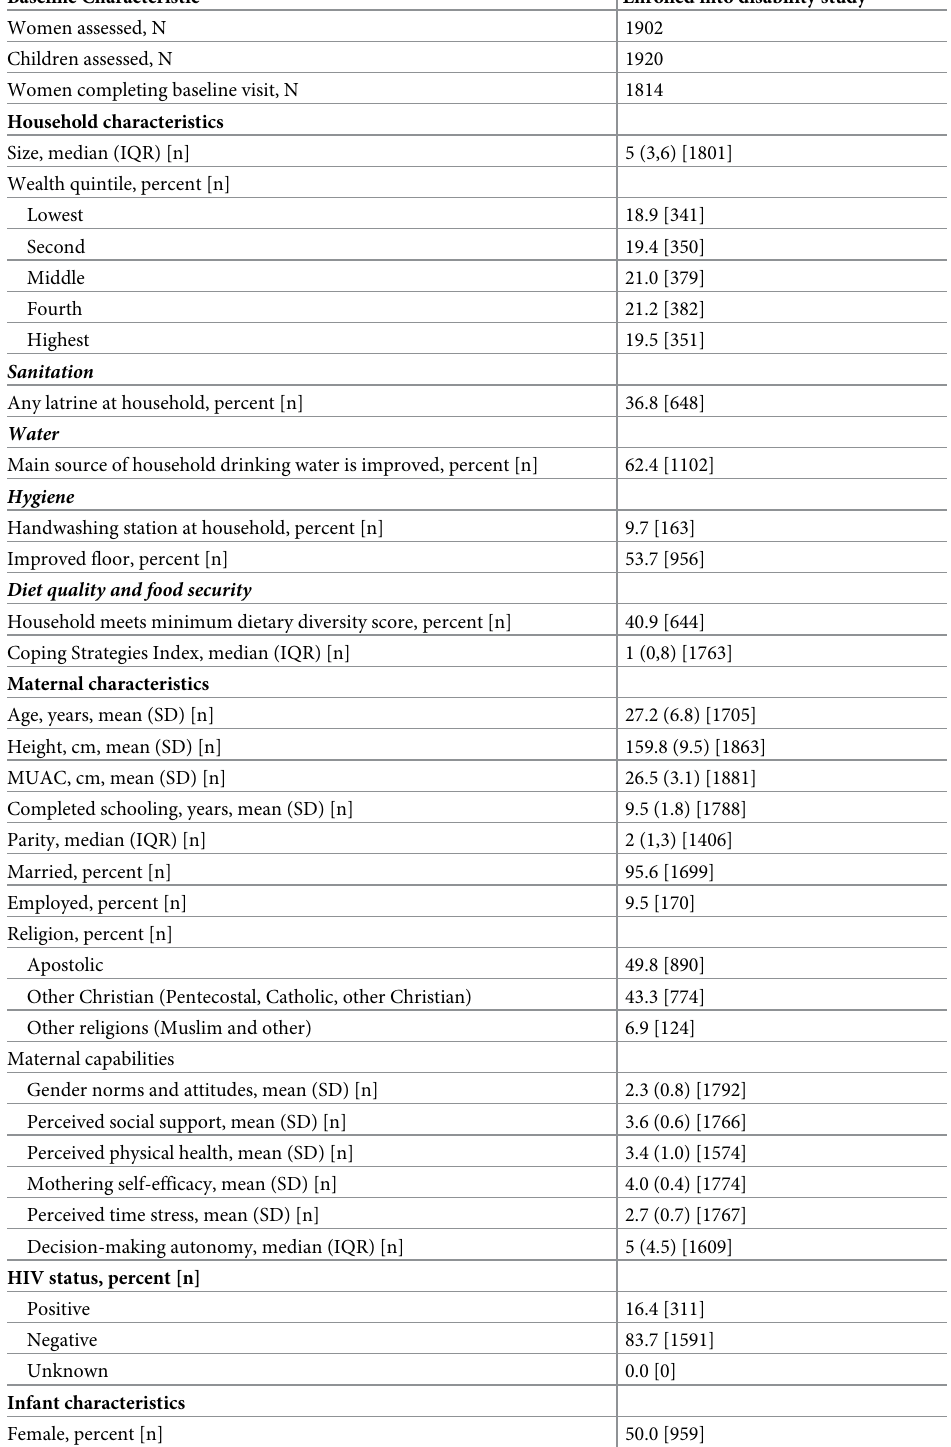
Table 1. Baseline characteristics of mothers and children in the disability sub study of the Sanitation Hygiene Infant Nutrition Efficacy (SHINE)